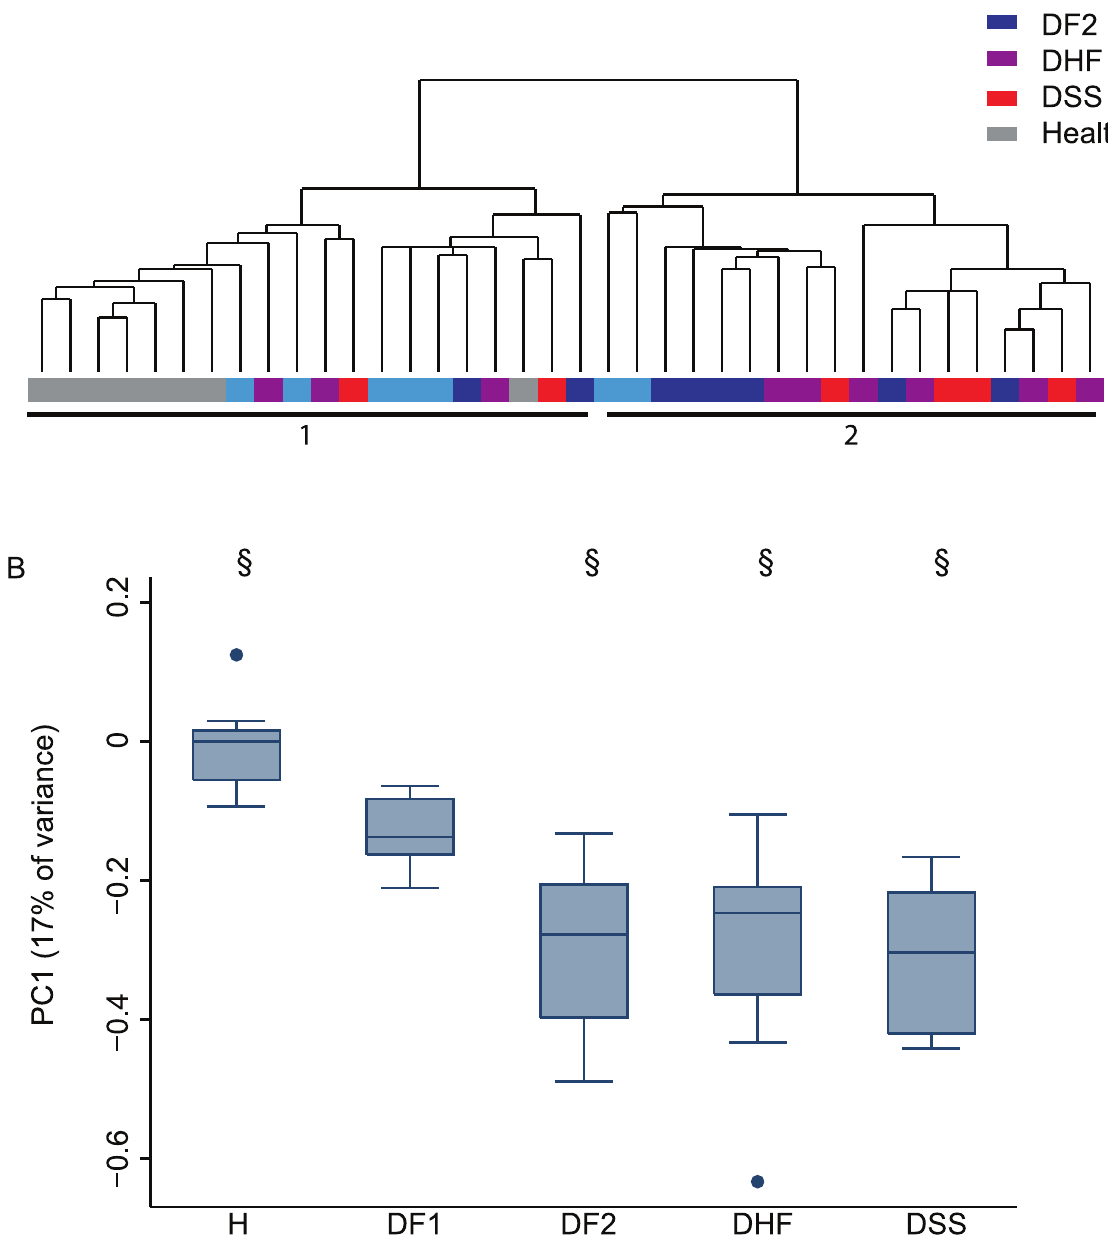
Figure 1. Gene expression in dengue patients on day 4 of fever. A) Hierarchical clustering of PBMC expression profiles from healthy individuals and dengue patients on fever day 4. Unsupervised clustering based on expression of 10,075 transcripts meeting quality control criteria (see Methods and Materials). Samples are colored by serologic status and WHO-defined clinical status. All patients with DHF or DSS had secondary DENV infection. Numbered horizontal bars refer to sample clusters described in the text. B) Values associated with principal component 1 from singular value decomposition of the data in (A). H=healthy control; DF1=dengue fever, primary DENV infection; DF2=dengue fever, secondary DENV infection; DHF=dengue hemorrhagic fever; DSS=dengue shock syndrome. 1 : differs from DF1 (p # 0.01, rank sum). outcome among the patients, the strongest source of variation in and the data from the 8 samples from healthy controls. One of the two major branches of the sample-based dendrogram included all the data was the history of prior DENV infection. Healthy healthy controls and 5 of 7 patients with DF1, while 16 of 18 individuals were at one end of the continuum defined by the value samples in the other branch came from individuals with secondary of the first principal component (PC1), and patients with secondary infection were at the other; those with primary DENV DENV infection (DF2, DHF, and DSS) (Fig. 1A, clusters 1 and 2). Principal components analysis clarified the structure suggested by infection had intermediate values of PC1 (Fig. 1B). The one DSS the clustering: despite marked differences in subsequent clinical patient with primary infection, an infant believed to have maternal